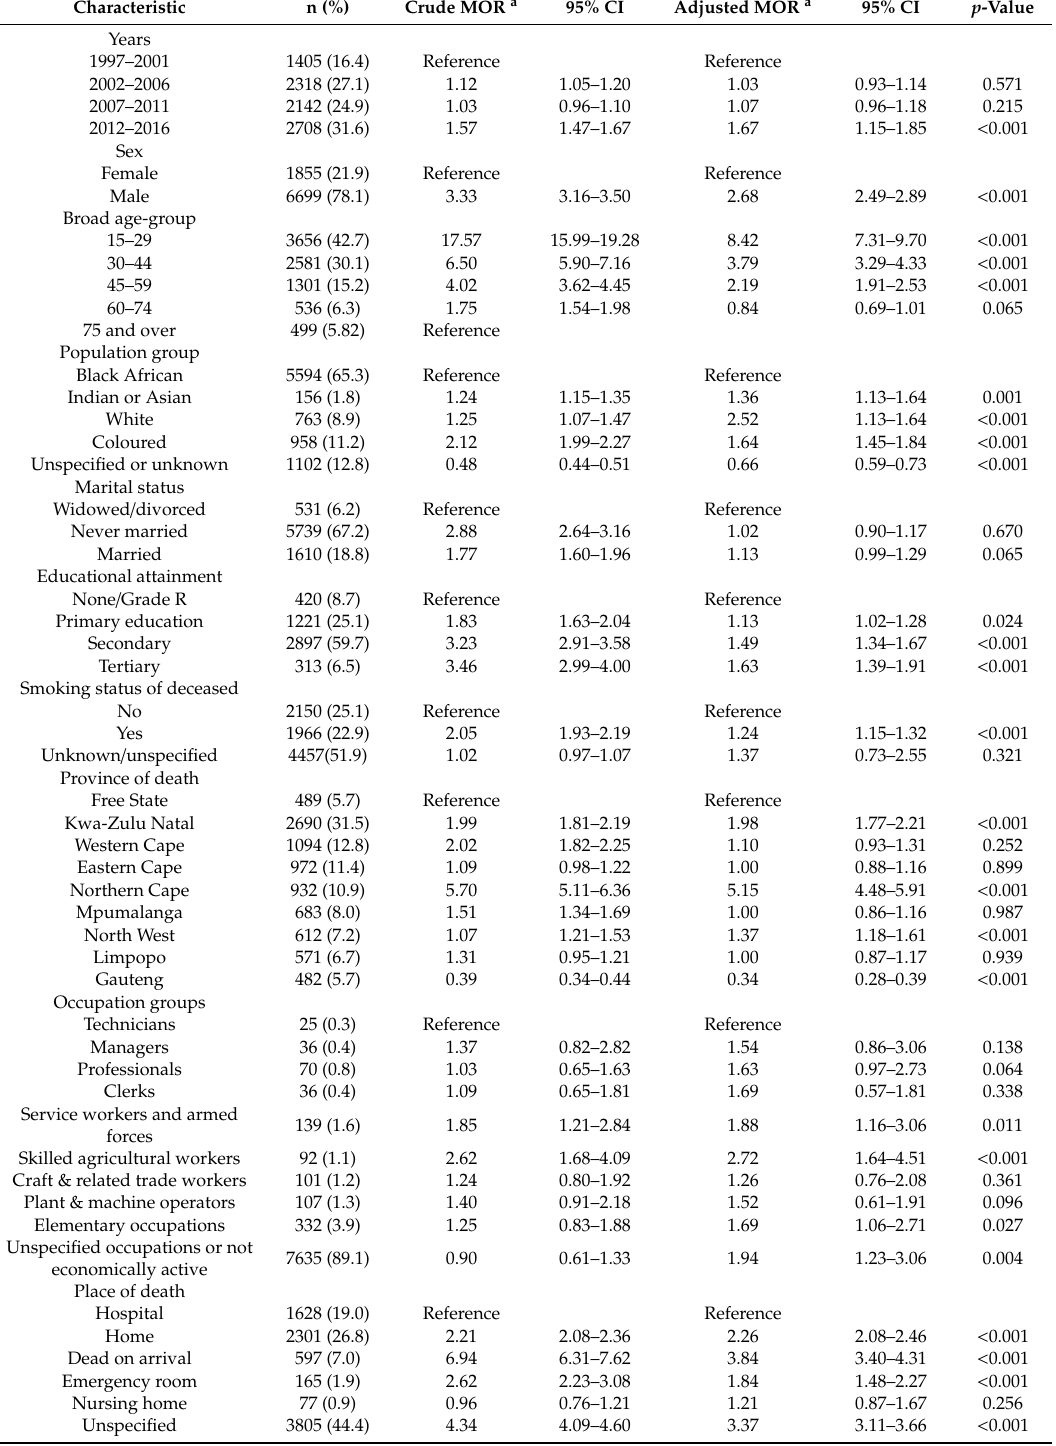
Table 1. Crude and adjusted suicide mortality odds ratios (MOR) of socio-demographic factors associated with suicide mortality in adults, 15 years and older (n =